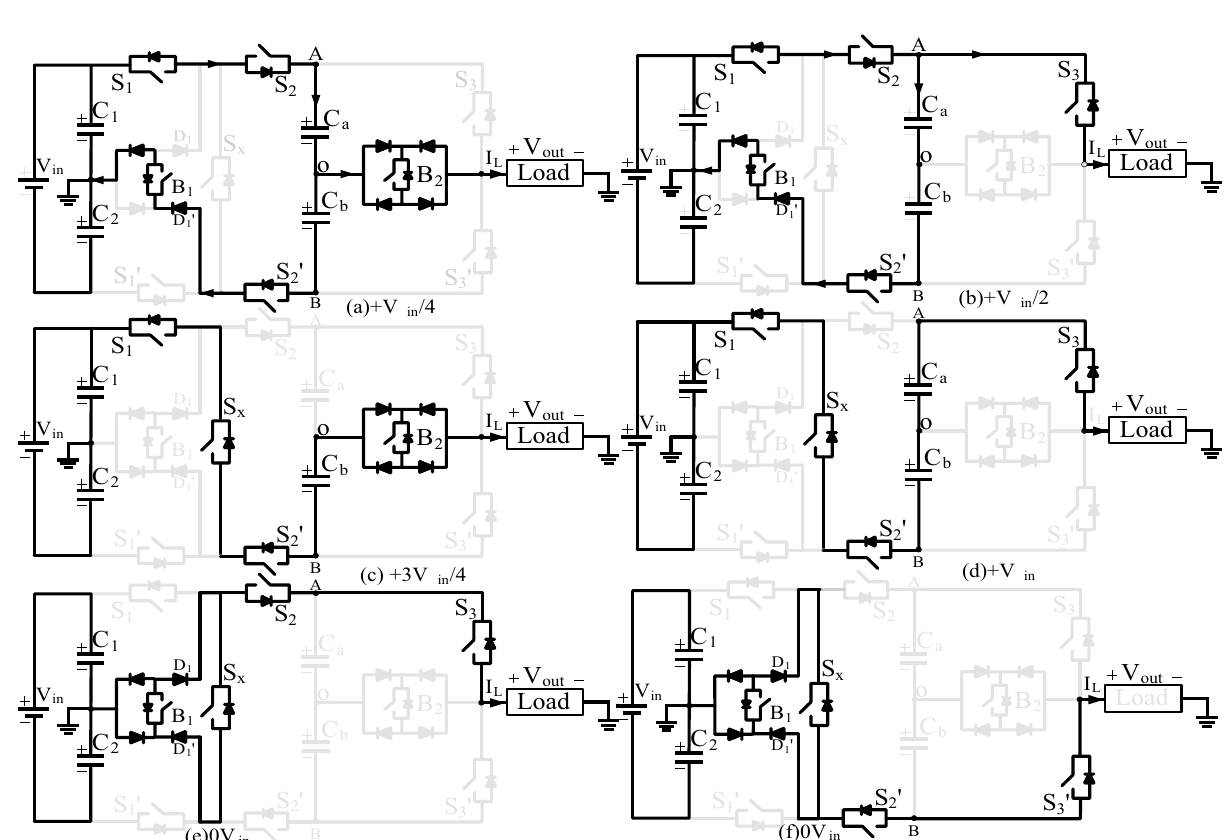
Figure 2. Proposed ANPC 9L-BSCI operation ( a – f ) modes of operation of the positive half